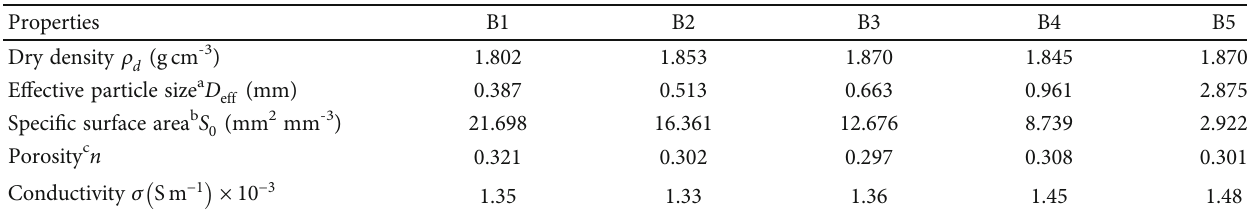
Table 6: Properties of SRM with di ff erent rock